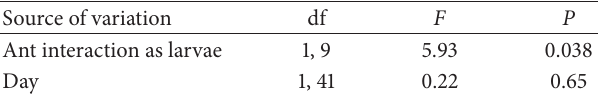
Table3:Resultsoflinearmixed-effectsanalysistestingtheinfluence of larval experience with ants and day on mean daily difference in egg number between host plants without and with C. floridanus ants present.